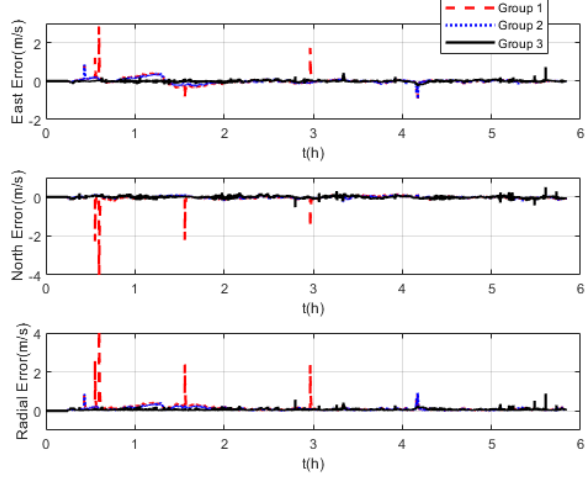
Figure 7. Comparison of velocity errors at mid − latitudes.